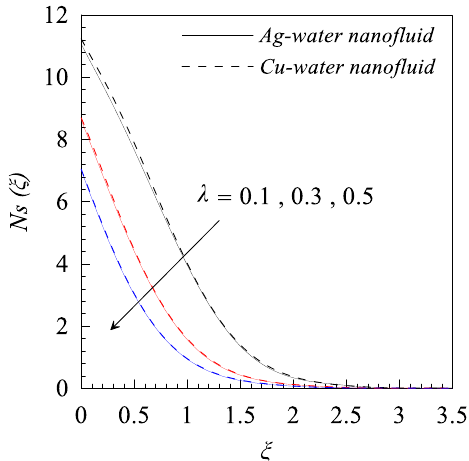
 on entropy generation Figure 7. Effects of temperature difference parameter λ on entropy generation Ns ( ξ ) when κ = 10,